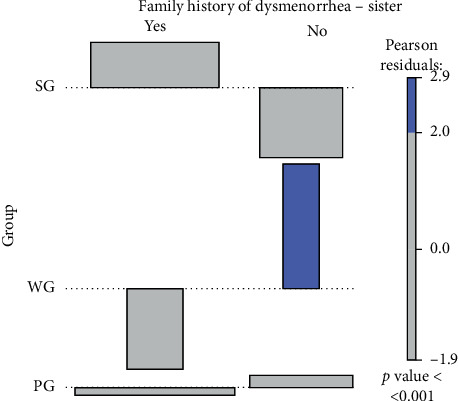
A diagram of multidimensional data association for respondents from individual groups (PG, SG, and WG) and the occurrence of dysmenorrhea in sisters of the respondents (answers: yes, no). A significant statistical relationship p < 0.001 was found between the multidimensional data. PG, women with dysmenorrhea during every cycle, SG, women with dysmenorrhea occasionally, and WG, women without dysmenorrhea.